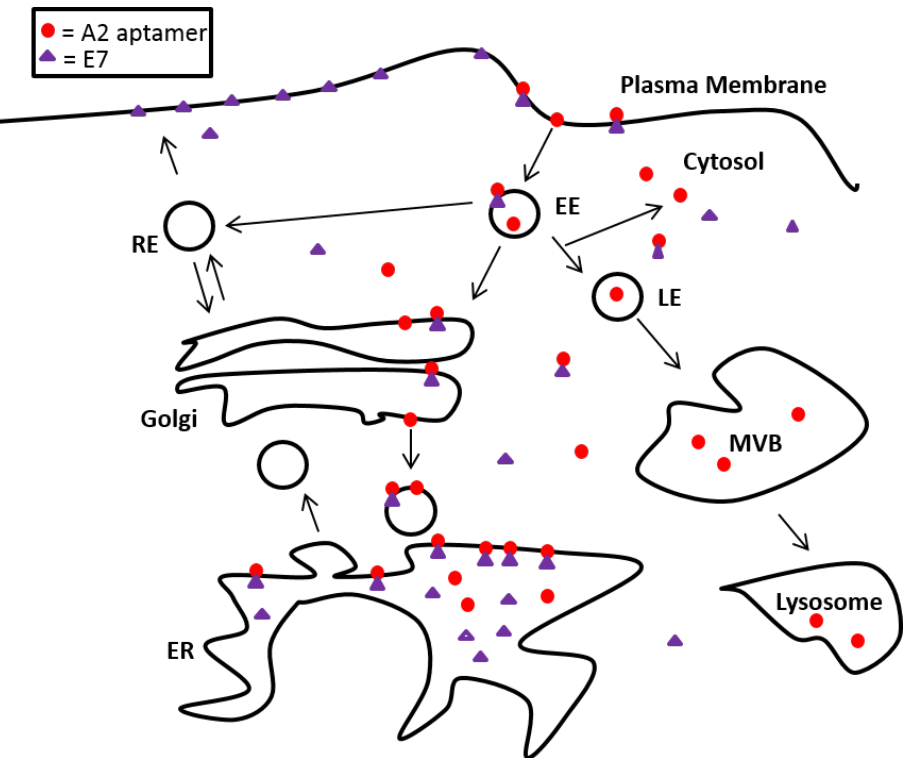
Figure 7. A2 can enter the cells alone or via the endosomal system. Upon contact with E7; either at the plasma membrane or intracellularly, A2 enhances E7 retention in the ER. This would be predicted to reduce E7 delivery to the plasma membrane via its normal biosynthetic route. ER: endoplasmic reticulum, EE: early endosome, LE: late endosome, MVB: multivesicular bodies, RE: recycling endosome.